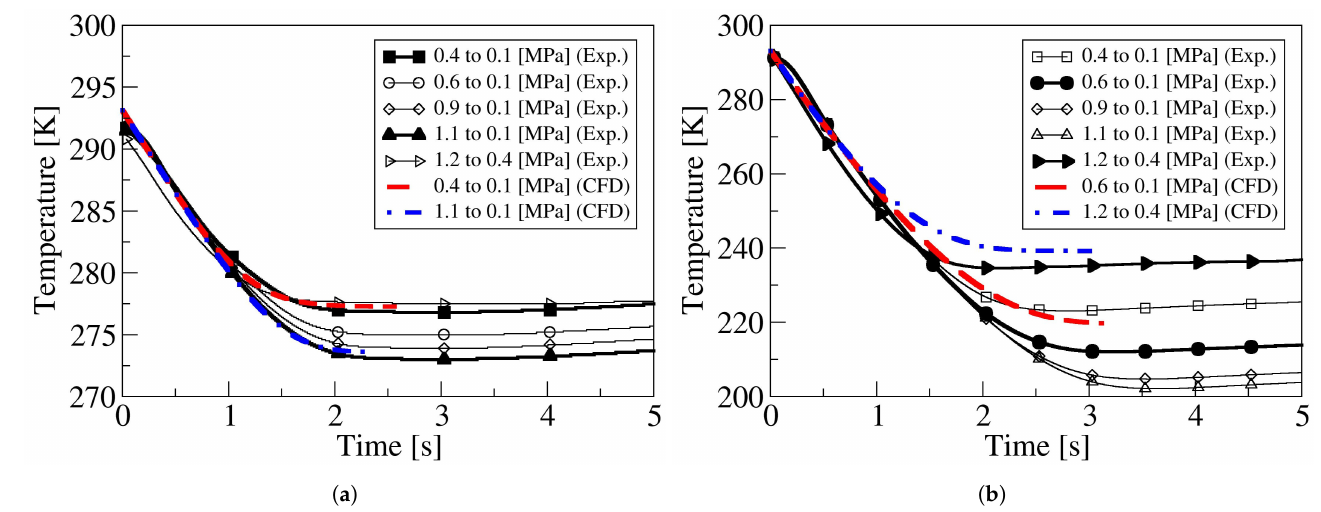
Figure 6. Experimentally-based and numerical temperature decay in the upstream reservoir. ( a ) The flow goes from the large to the small reservoir. ( b ) The flow goes from the small to the large